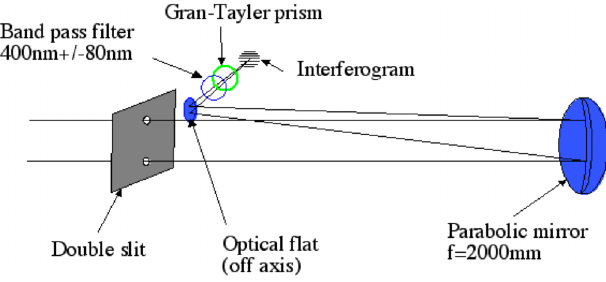
FIG. 4. (Color) Schematic layout of the SR